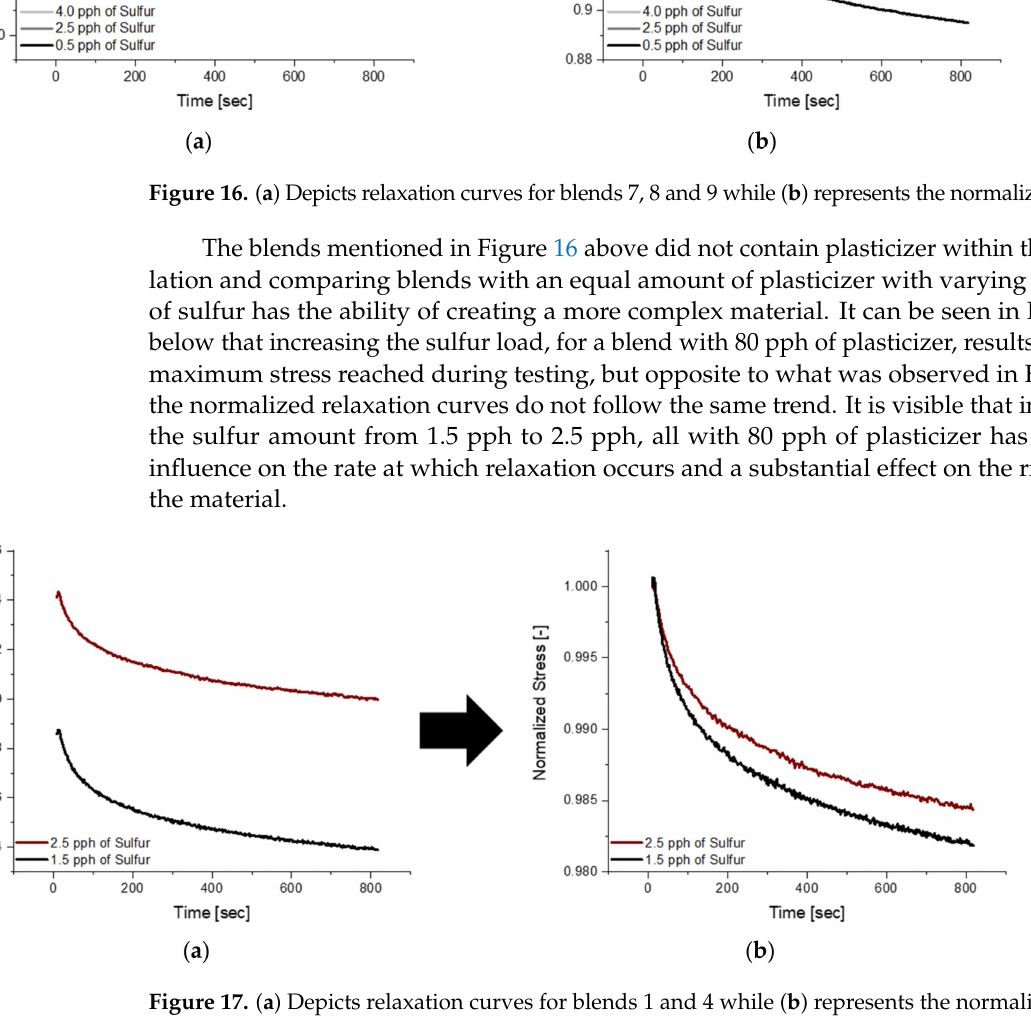
Figure 17. ( a ) Depicts relaxation curves for blends 1 and 4 while ( b ) represents the normalized curve, showing a large similarity in regard to the stress decay